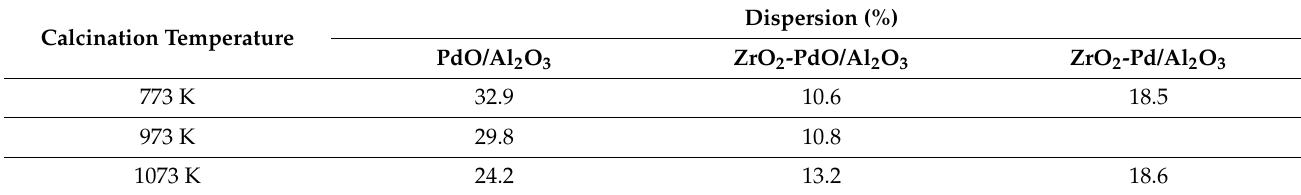
Table 1. Pd metal dispersion in different Pd-supported